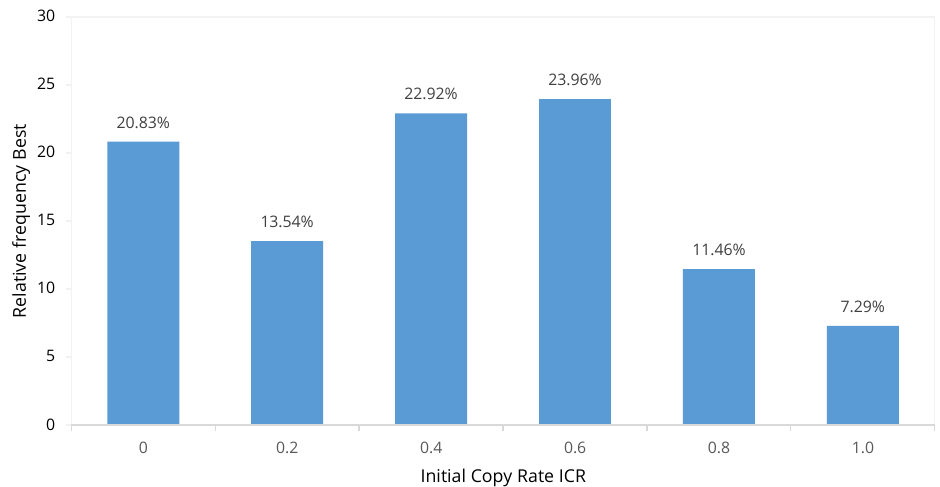
Figure 7. Comparison frequency Best between random and copied initial solutions.